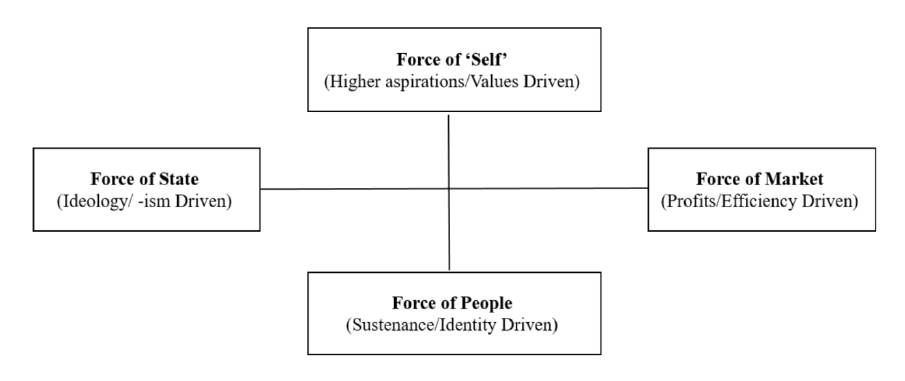
Fig. 1: “Four-Forces Framework of Democracy” and their